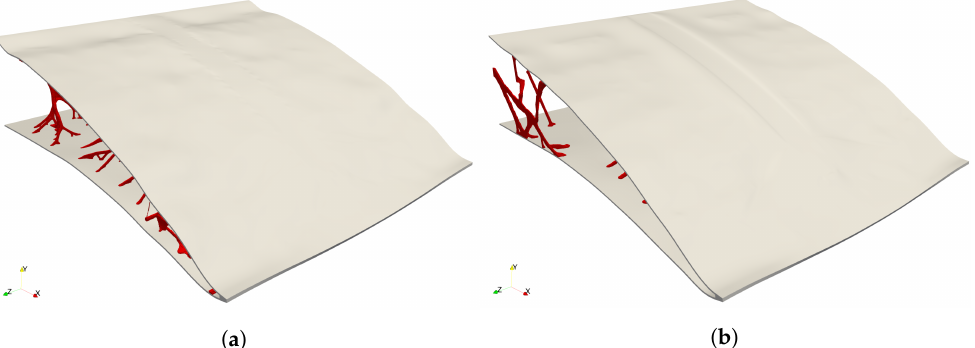
Figure 11. Deformation fields of ( a ) Density approach with two design domains. ( b ) Feature mapping. Small defects in the skin are seen as a result of the morphing displacement